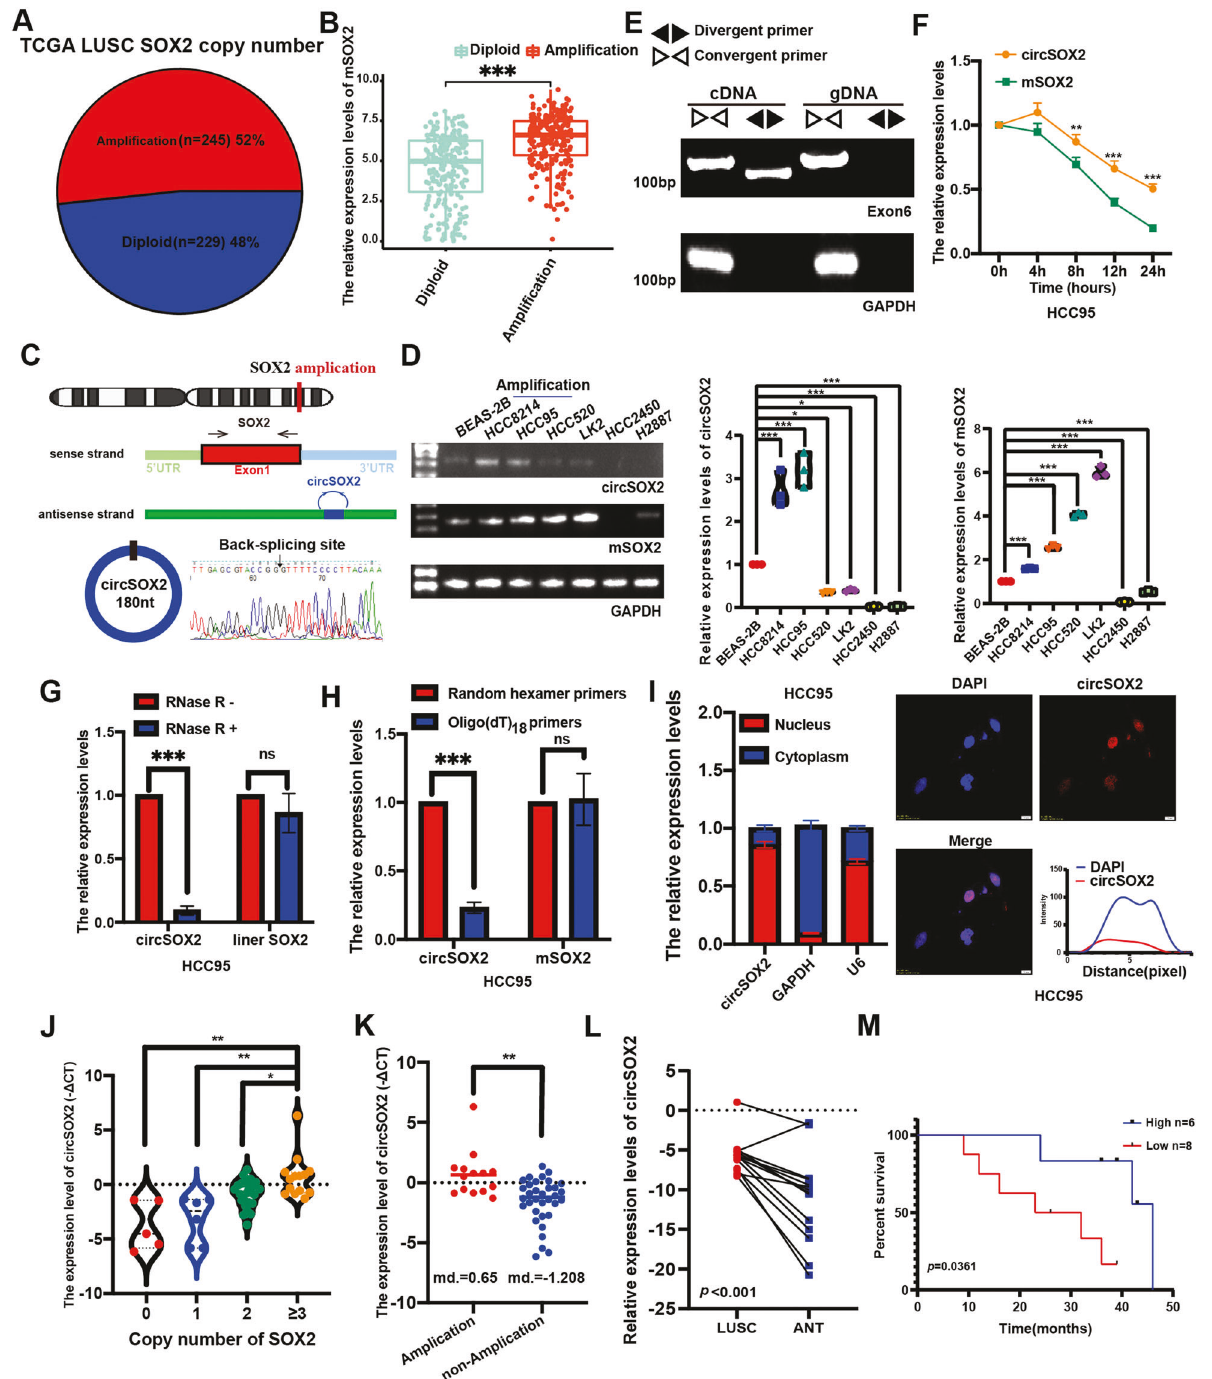
Fig. 1 CircSOX2 could ef fi ciently express in SOX2 ampli fi ed LUSC. A Pie chart of SOX2 copy number and relative proportion of LUSC in TCGA. B SOX2 coding transcript (mSOX2) was expressed higher than the diploid group of LUSC in TCGA. C The diagram illustrating the production of circSOX2. The circSOX2 was determined by Sanger sequences, and the back-splicing site has been denoted by arrows. D DNA gel presented the expression level of circSOX2 and mSOX2. CircSOX2 was effectively expressed in SOX2-ampli fi cated LUSC cell lines. E CircSOX2 can only be ampli fi cated by divergent primers. F CircSOX2 was more stable than mOX2 upon being treated with Actinomycin D. G CircSOX2 signi fi cantly resisted the degradation of RNase R. H CircSOX2 could not be reverse transcripted by poly(A)-dependent Oligo(dT) 18 primers. I Nuclear and cytoplasmic fraction qRT-PCR and fl uorescent in situ hybridization (FISH) revealed that circSOX2 is predominantly located in the nucleus. J The expression levels of circSOX2 in various SOX2 copy numbers. K CircSOX2 was effectively expressed in the SOX2 ampli fi cation group of LUSC. L The expression level of circSOX2 in LUSC and the adjacent normal tissues. M Kaplan – Meier curve demonstrated that SOX2-ampli fi ed LUSC patients with higher circSOX2 had better survival. *** p < 0.001, * p < 0.05, ns: no signi fi cant.